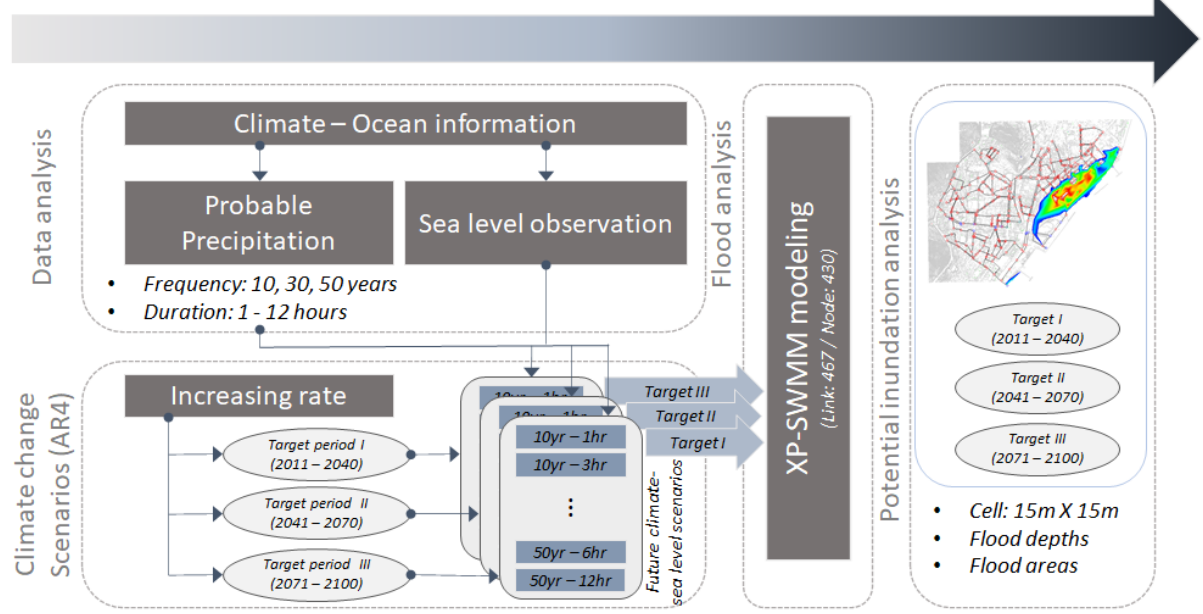
Figure 2. Flowchart of this